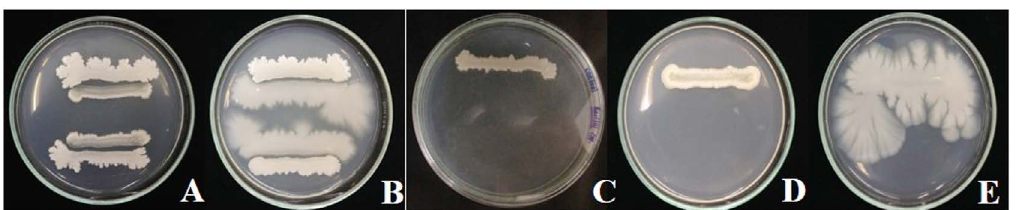
Fig. 6. Compatibility test of antagonistic bacteria B. pumilus FDKF5 or Bacillus IKM1 and Bacillus bio-product A: Bacillus bio-product and Bacillus pumilus